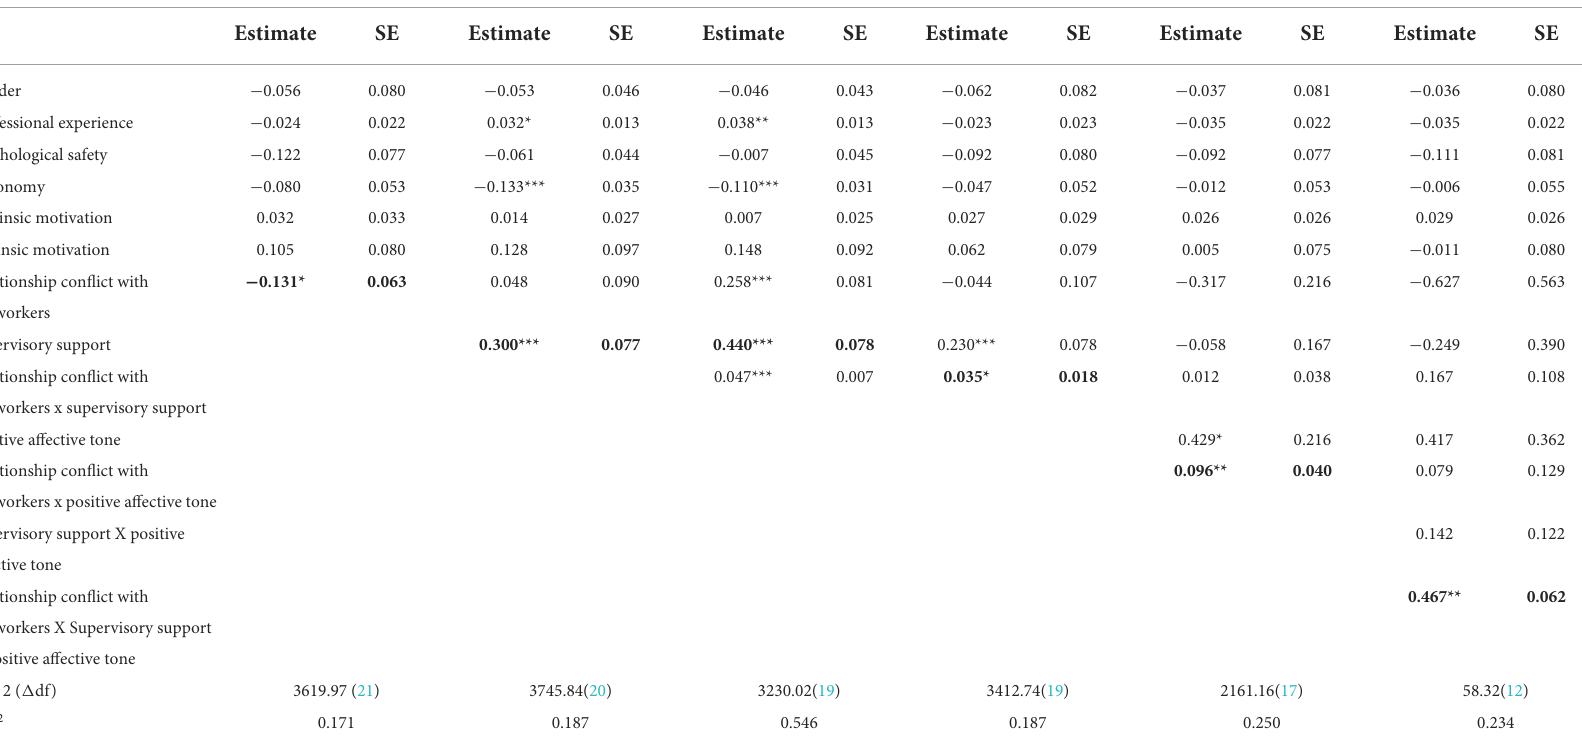
TABLE 2 Random coefficients regression analyses.